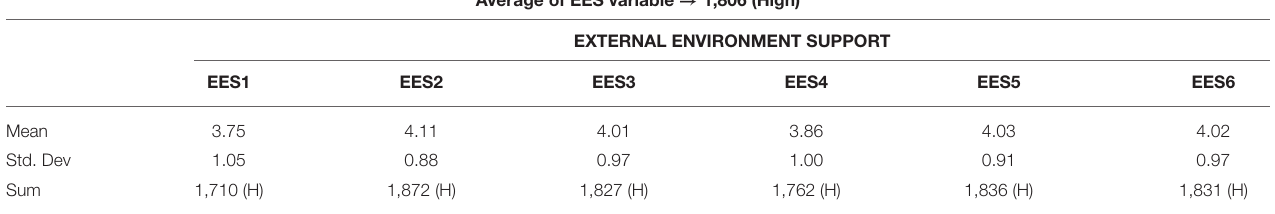
TABLE 5 | Descriptive analysis of EES perception.